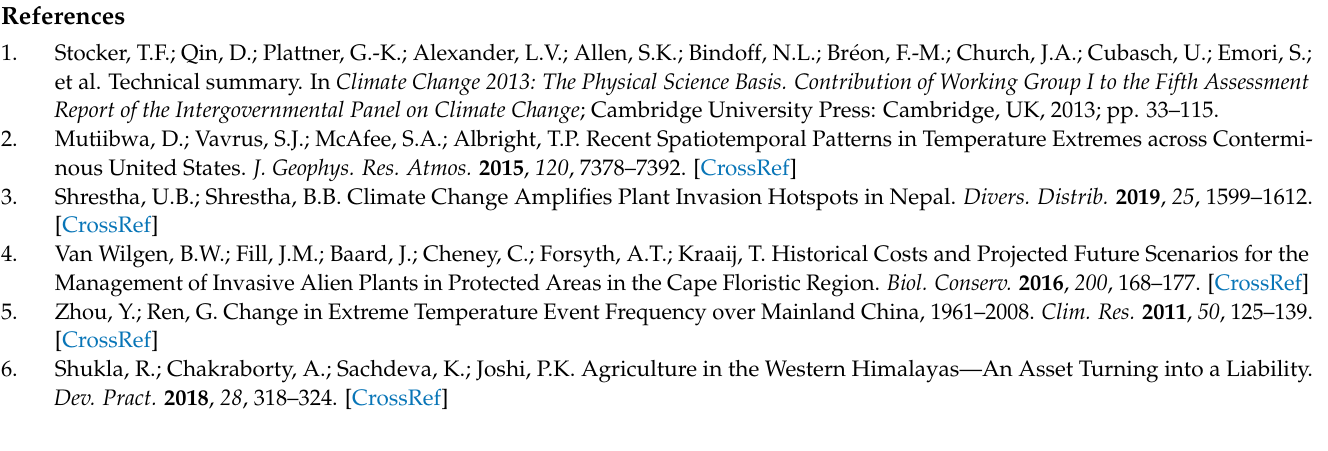
over the basin. Figure S5. Spatial distribution map of all the 16 extreme climate indices based on the Hurst exponent. Figure S6. Spatio Temporal trends in the total temperature(MIN) for different months(January–December). The figure provides the Sen slope of the trend in each grid, which has significant trends. Figure S7. Spatio Temporal trends in the total temperature(MIN) for different seasons(Autumn–Winter) & Annual time scale. The figure provides the Sen slope of the trend in each grid, which has significant trends. Figure S8. Spatio temporal variation of all the 16 extreme climate indices over the basin. Figure S9. Spatial distribution map of all the 16 extreme climate indices based on the Hurst